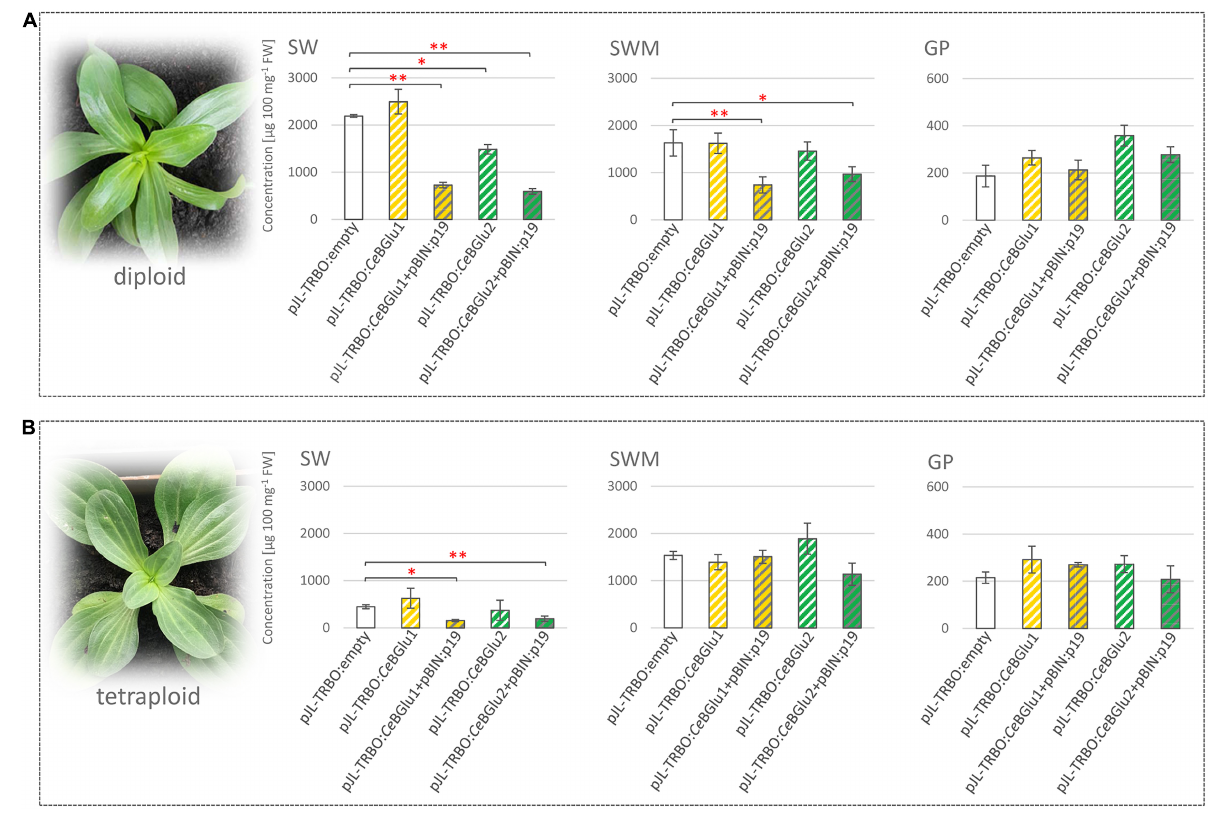
FIGURE 7 | Agroinfiltration of leaves of diploid (A) and tetraploid (B) C. erythraea plants. Changes in the content of secoiridoid glucosides (SGs) swertiamarin (SWM), sweroside (SW) and gentiopicrin (GP) 5 days following agroinfiltration were recorded: Ce BGlu1 and Ce BGlu2 cloned into pJL-TRBO expression vector, were co-expressed either without or with silencing inhibitor p19 (pBIN:p19 construct). Results are expressed as means ± SE. Red asterisks denote significantly different values according to the t- test, p -values, * p < 0.05, ** p <